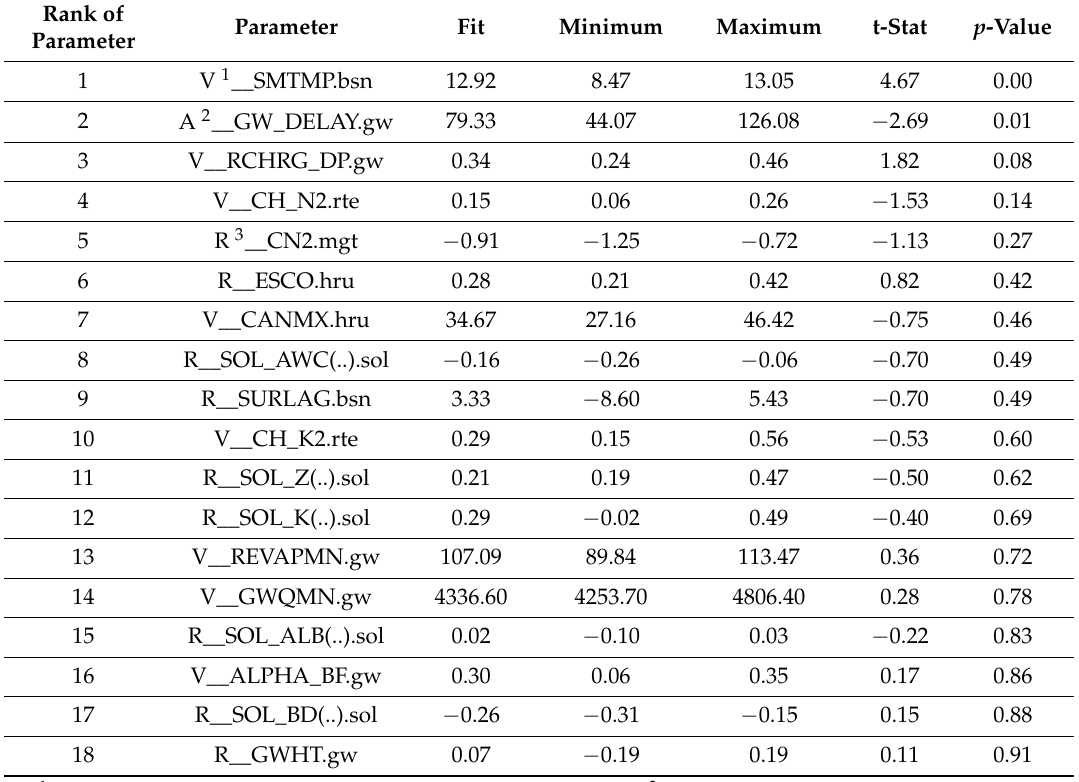
Table 2. Sensitive calibration parameter uncertainty at daily data